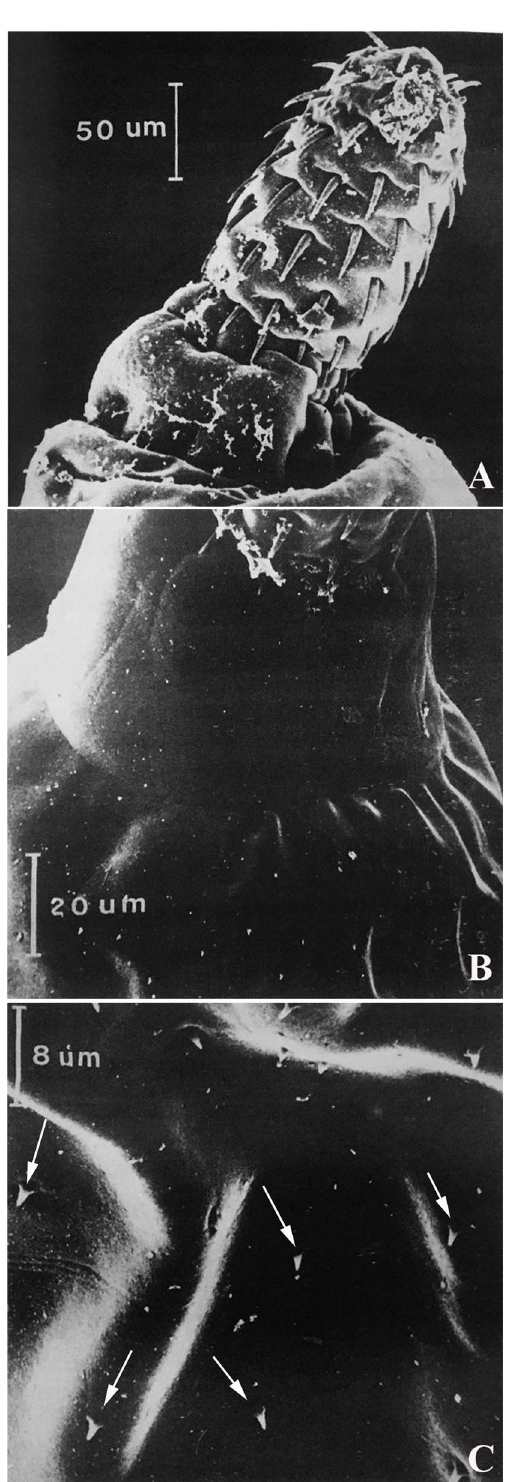
Figure 2. SEM photographs of Harpagorhynchus golvaneuzeti gen. n. sp. n. A) Proboscis; B) Neck with anterior part of trunk; C) Tegumental spines